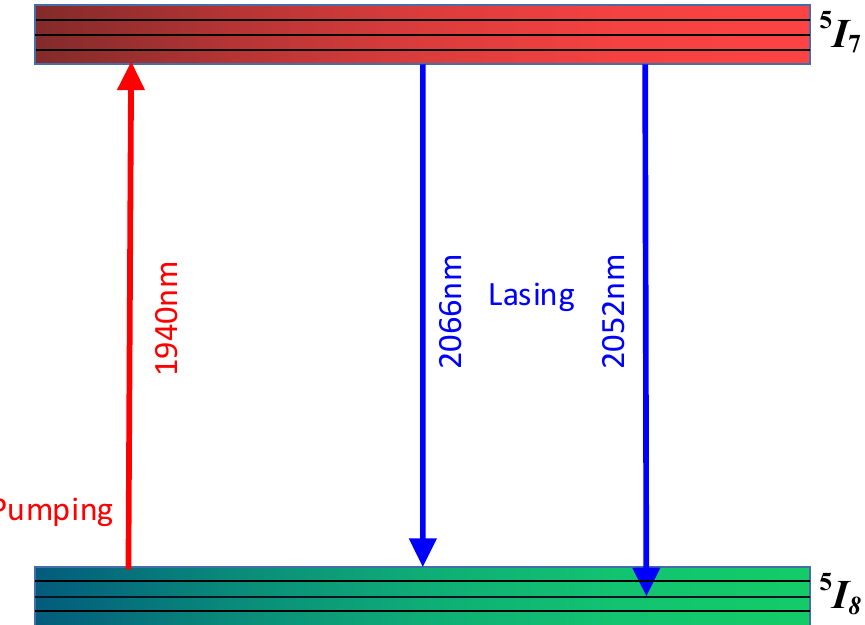
Figure 3. Energy levels in the Ho:LLF crystal [13,14].